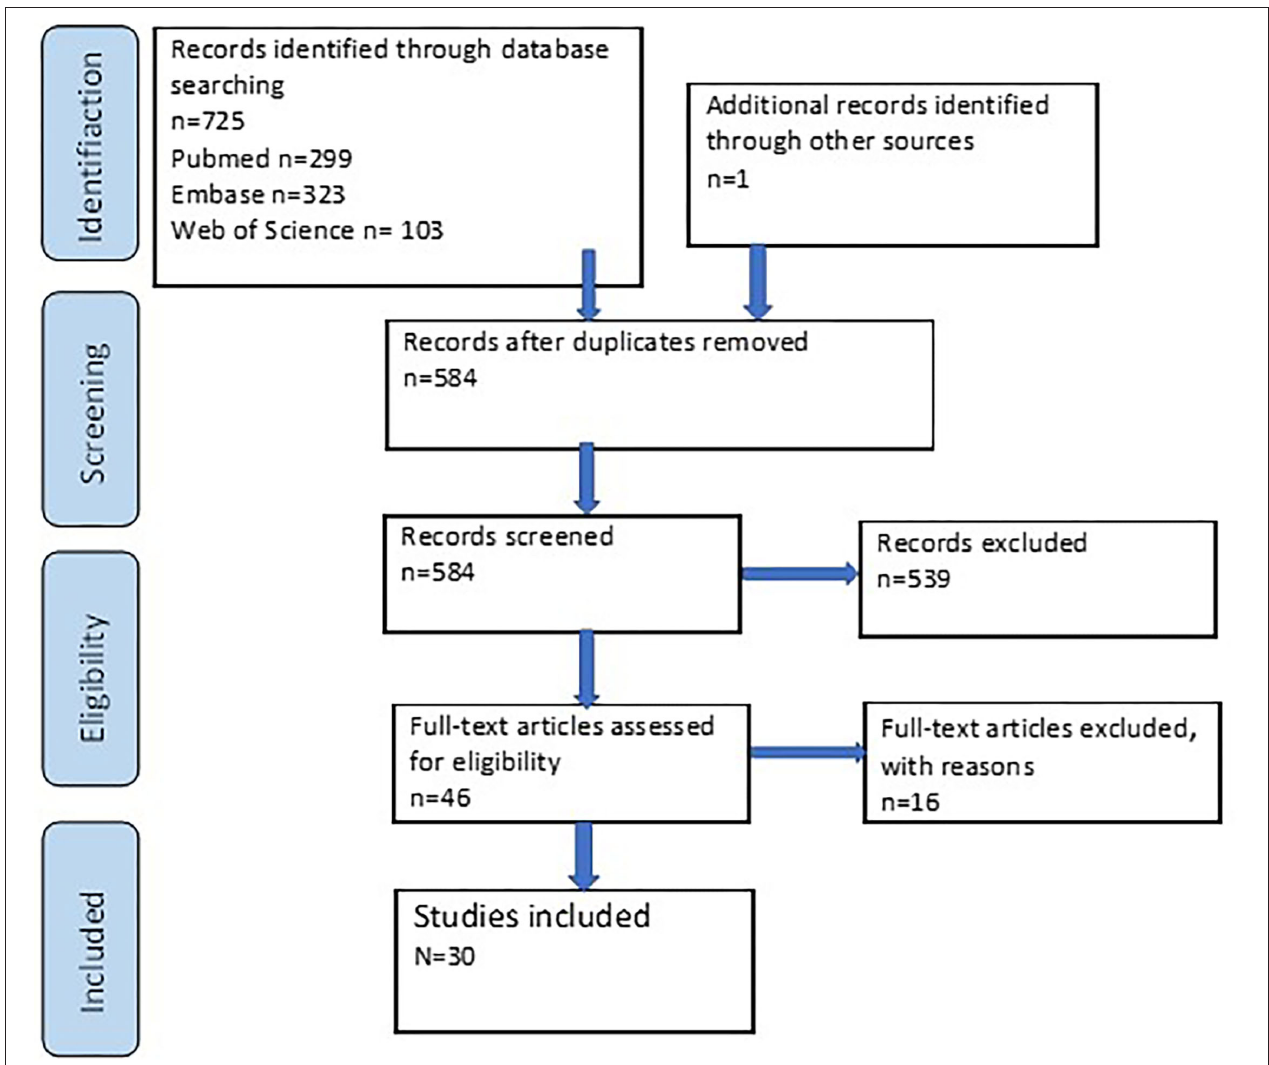
FIGURE 1 | Flowchart of the literature search strategy. Records were included or excluded based on the beforehand defined criteria.